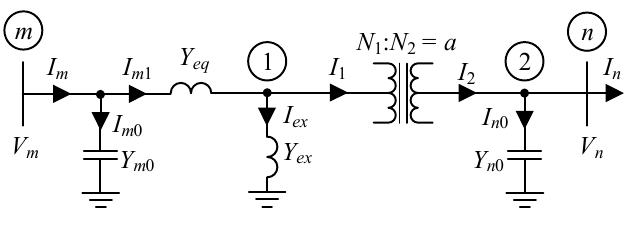
Figure 3. Transformer with a secondary-side tap.